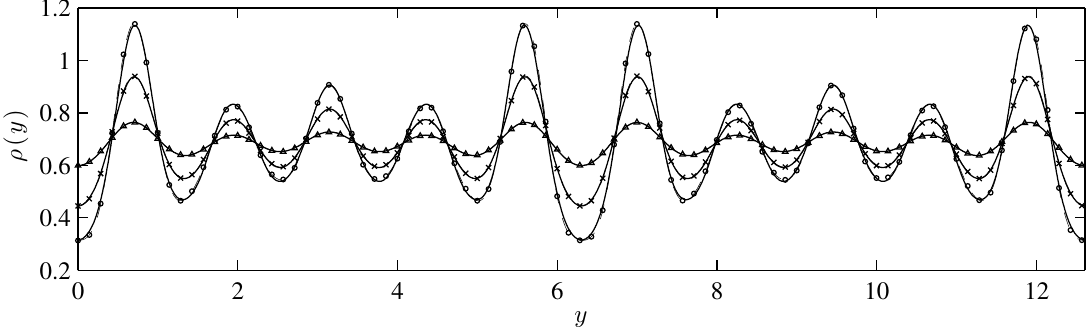
Figure 7. Comparison between density profiles obtained directly from MD simulations and the predictions of the truncated functional expansion using previously computed response functions for a three component SLF with m 1 = 6, m 2 = 8 and m 3 = 10. Bold lines without symbols represent MD = 0.5. Thin dashed lines = F y = F y simulations. Thin dashed lines indicated with triangles are for F y 6 8 10 = F y = F y = 1.5. Thin dashed lines indicated with circles are for indicated with crosses are for F y 6 8 10 = F y = F y = 2.5. Reprinted figure with permission from Dalton, B.A.; Glavatskiy, K.S.; Daivis, P.J.; F y 6 8 10 Todd, B.D. Phys. Rev. E 92 , 012108 (2015). Copyright (2015) by the American Physical Society